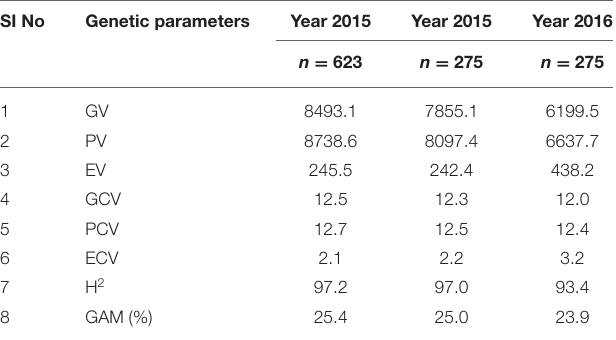
GV, PV, and EV, Genetic phenotypic and environmental variances; GCV, PCV, and ECV, Genetic, phenotypic and environment coefficient of variation; H 2 , broad sense heritability; GAM, Genetic advance over mean.